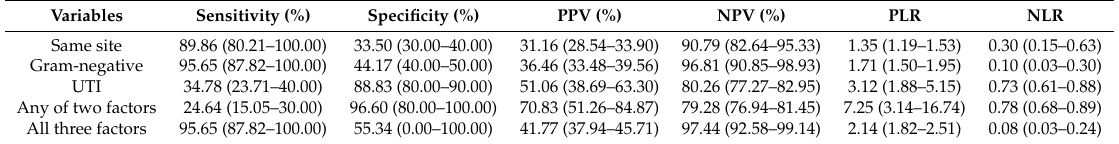
Table 5. Performance Parameters for Predictors of Same Organisms in Study